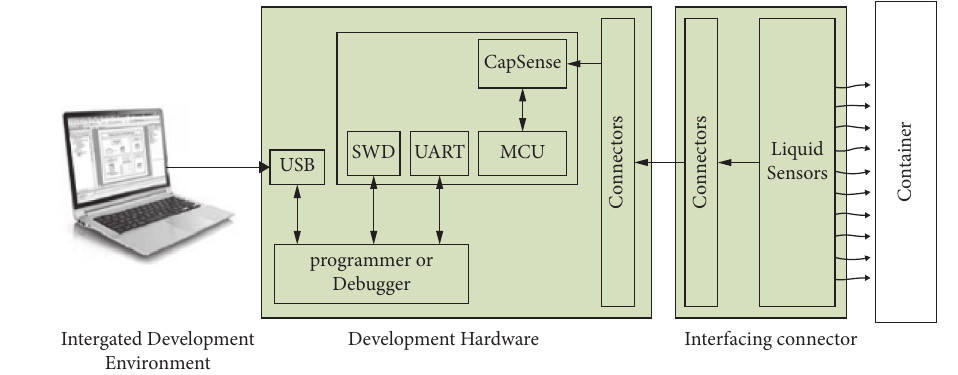
Figure 3: System-level diagram.